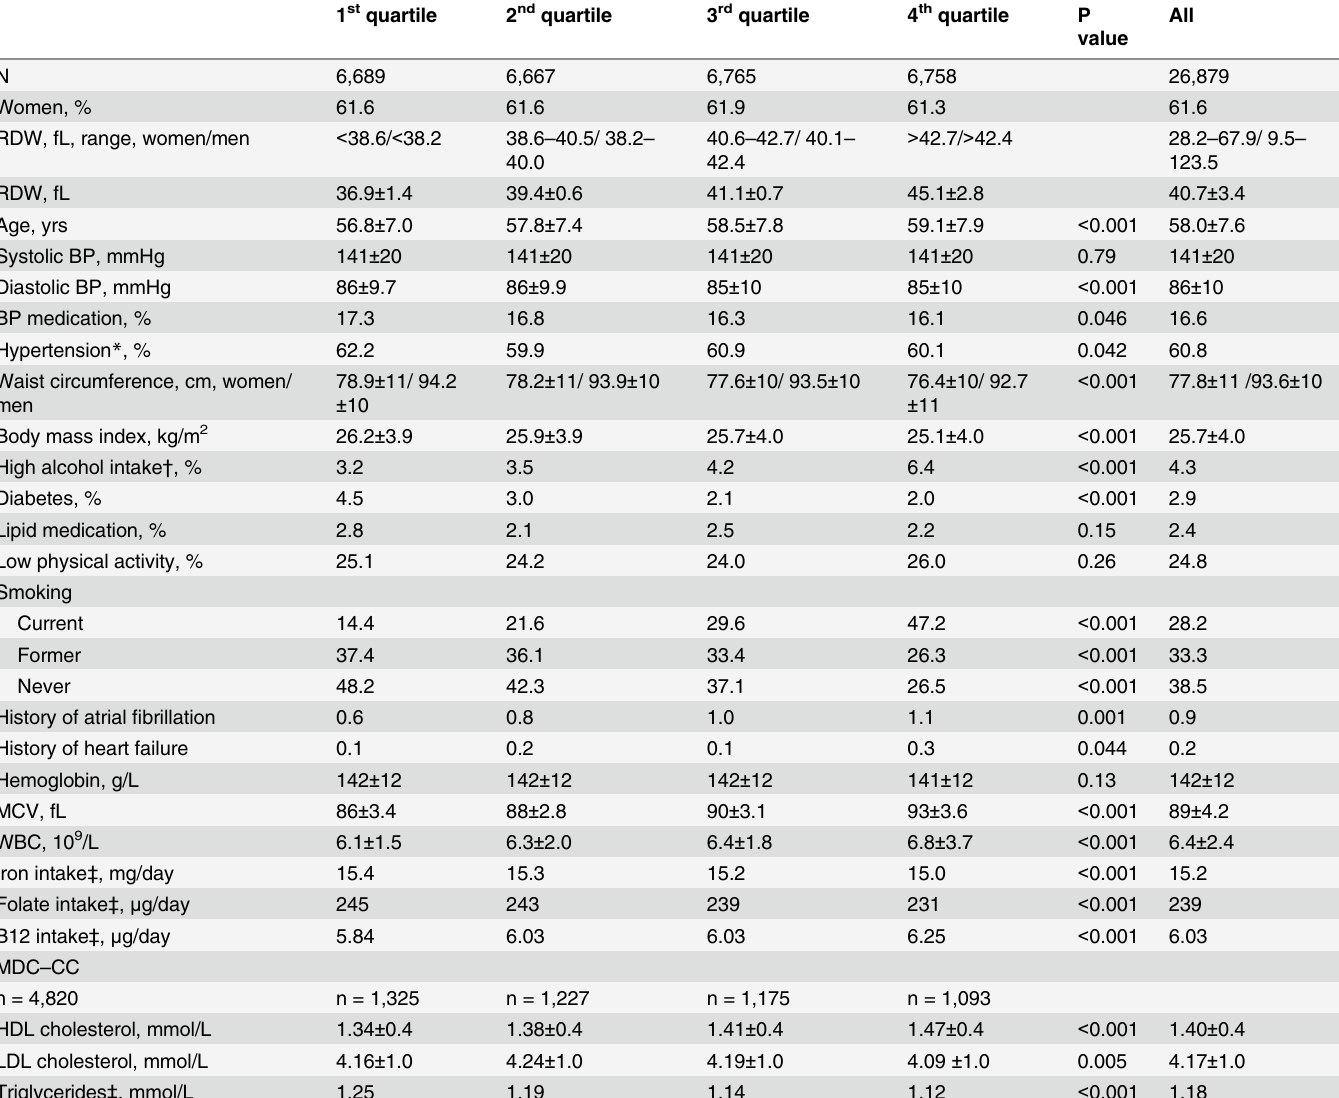
Table 1. Baseline characteristics by sex-specific quartiles of red cell distribution width